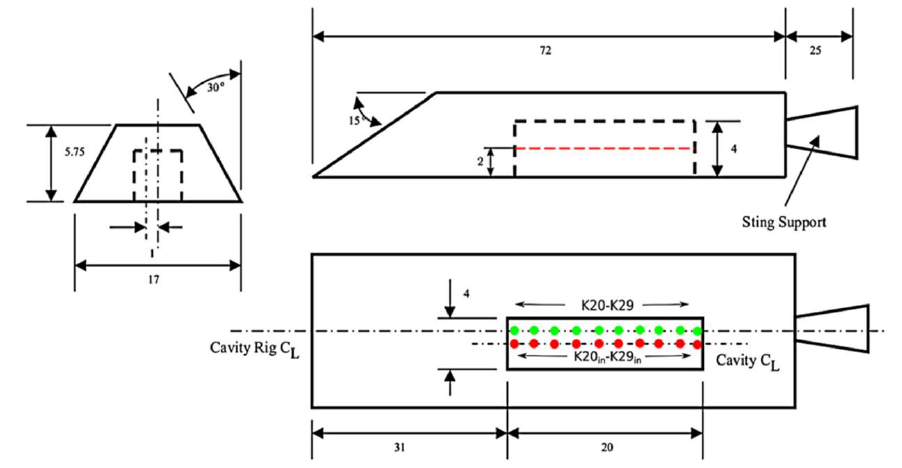
Figure 10. The geometry of the M219 cavity.